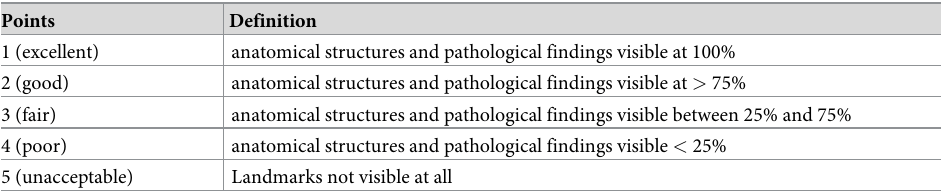
Table 2. Likert scale for subjective image quality.